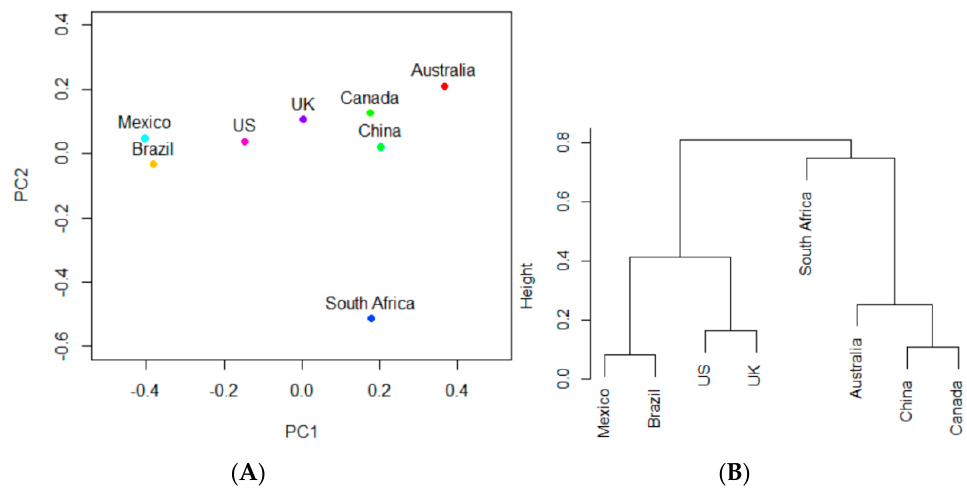
Figure 7. ( A ) projections of South Africa, Mexico, Canada, the UK, the US, Brazil, China, and Australia onto the PC1-PC2 space based on the occurrence of foodborne pathogens shown in Table 3; ( B ) clustering the countries based on their projections in ( A ).